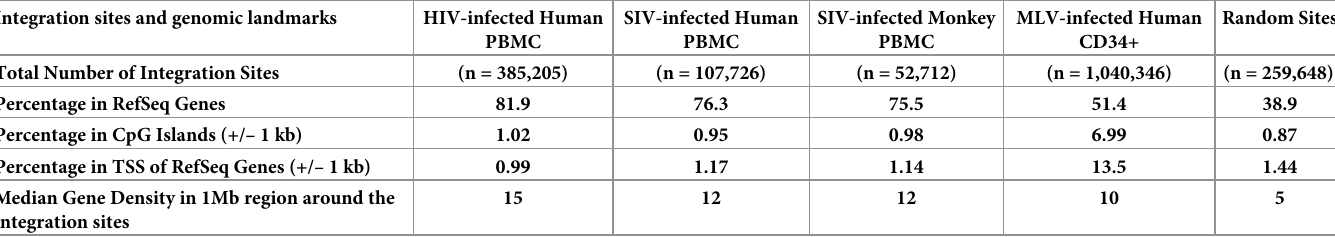
Table 1. SIV and HIV integration sites in relation to features in the human